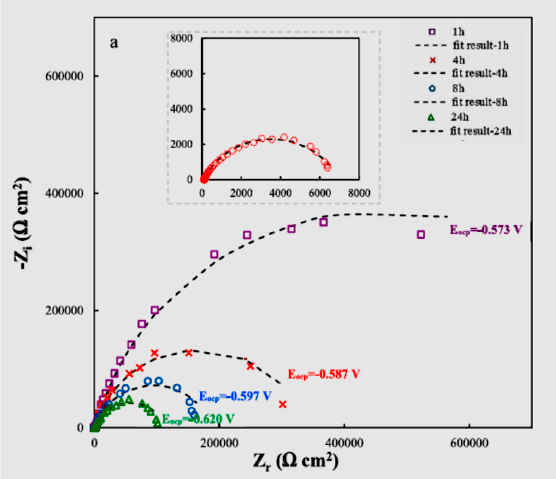
Figure 7. EIS and Nyquist plot for MIL-53 MOF sol-gel coating for different times of immersion